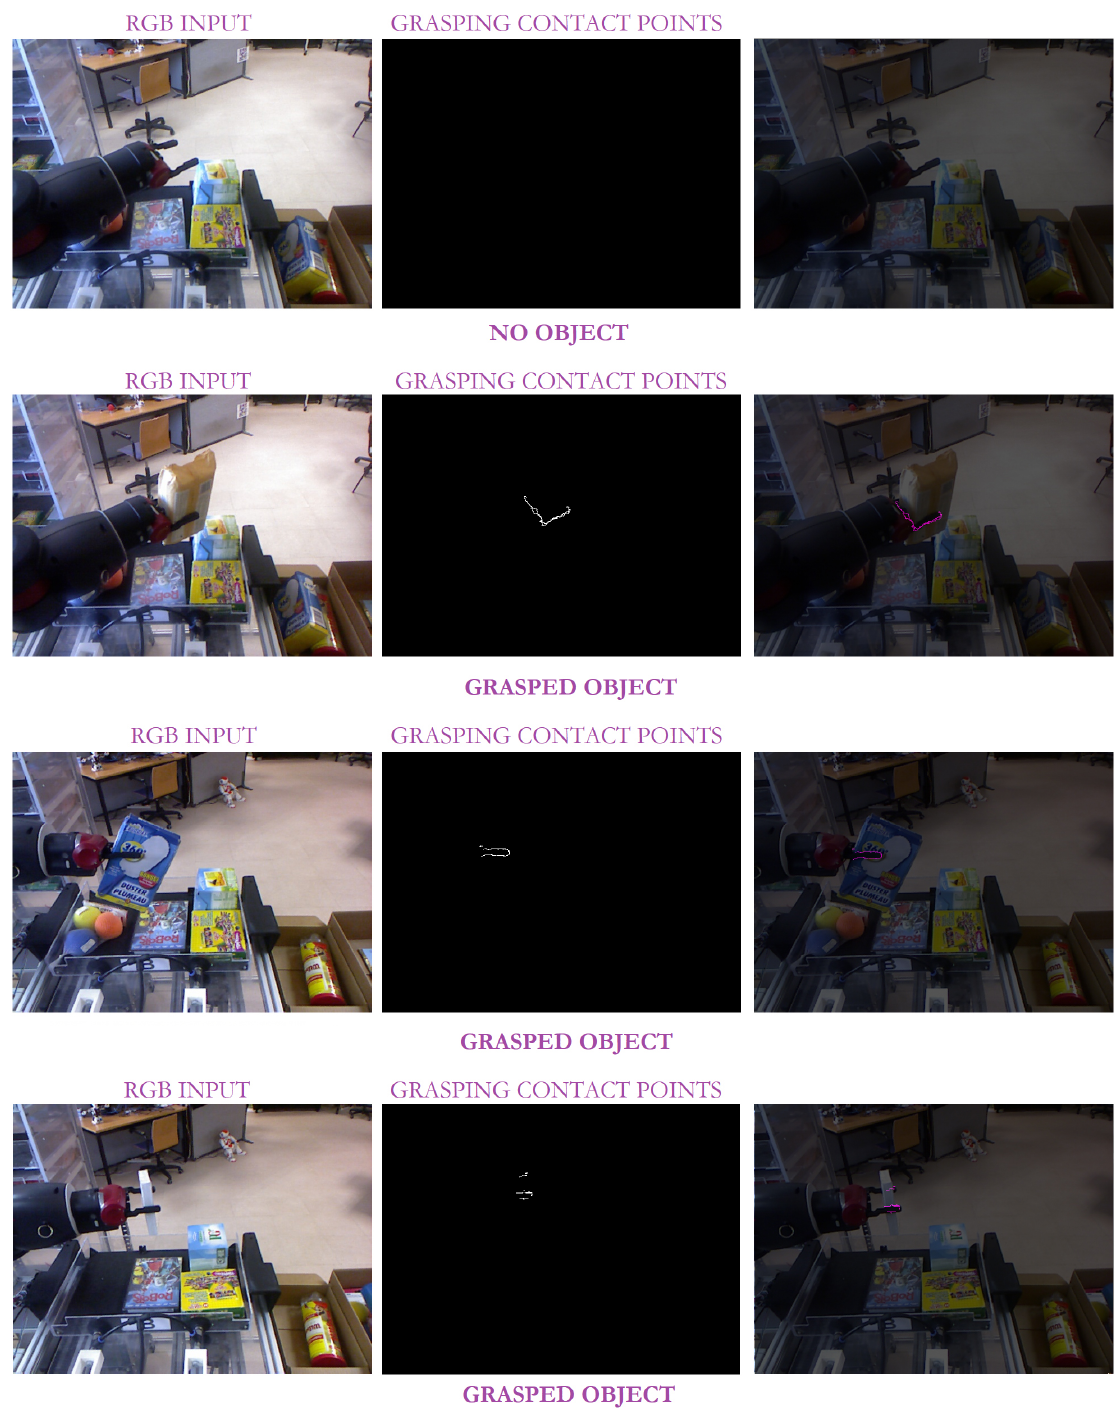
Figure 11. Some experimental results of our approach with the Baxter robot in pick-and-place tasks: the left column corresponds to the input RGB image; the middle column illustrates the detected contact points; and the last column shows the overlapping between the original image and the detected contact points (in